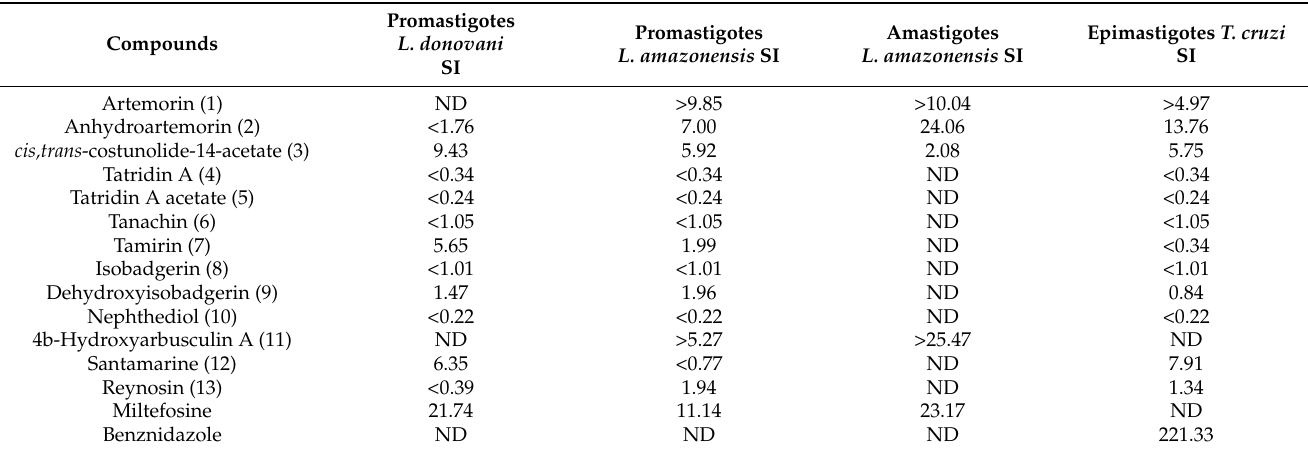
Table 2. Selectivity indexes (SIs) of compounds 1 – 13 isolated from the coral Palythoa aff. clavata against kinetoplastid species. The miltefosine and benznidazole were included as reference treatments. ND: not